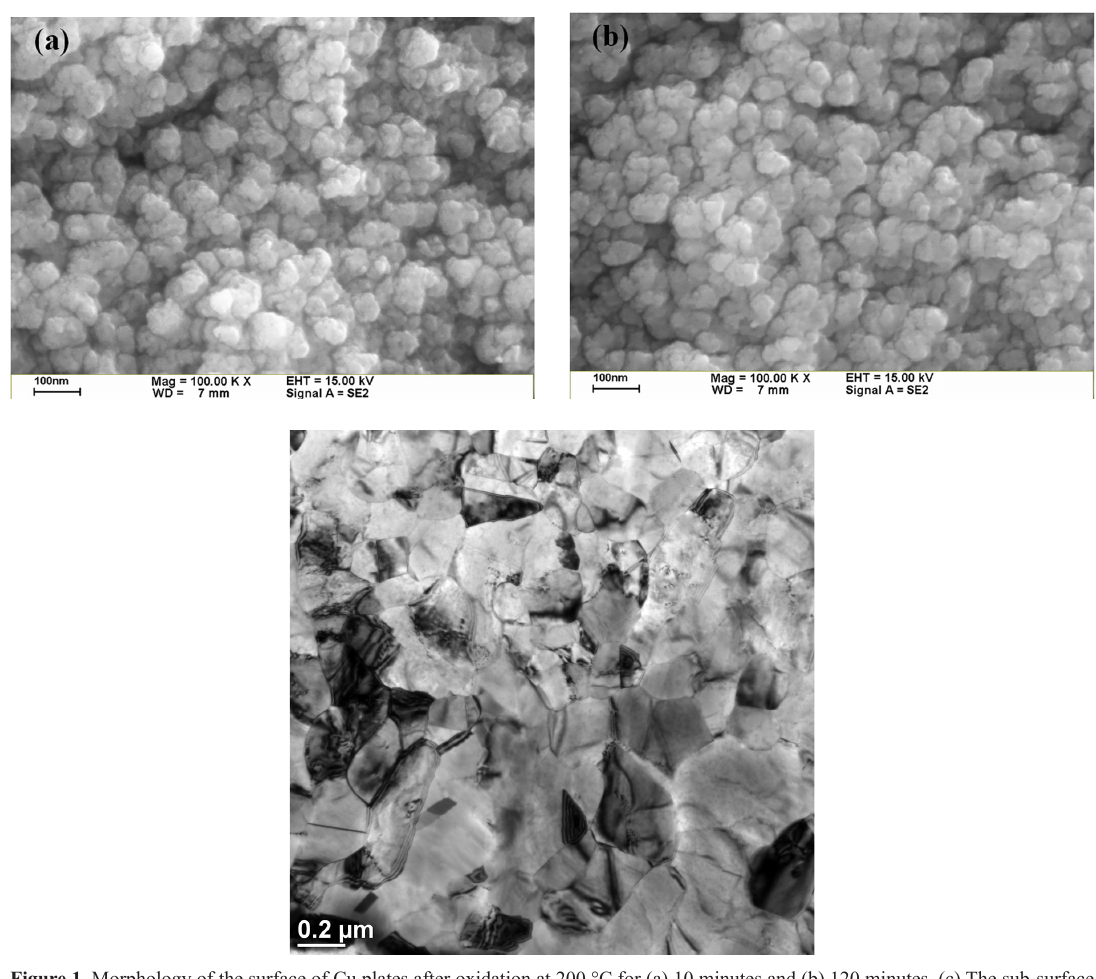
Figure 1. Morphology of the surface of Cu plates after oxidation at 200 °C for (a) 10 minutes and (b) 120 minutes. (c) The sub-surface structure of the Cu plate after oxidation at 300 °C for 120